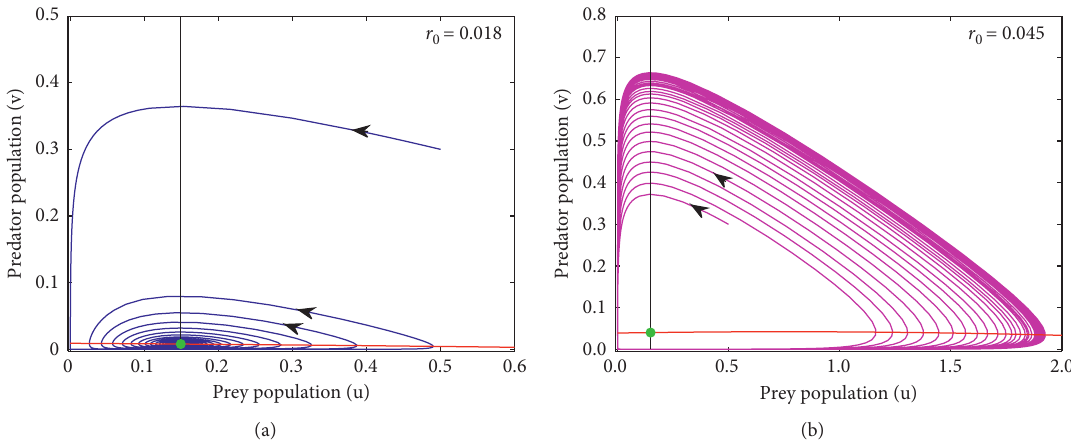
Figure 4: The phase portrait diagram of (4) around the coexisting singular point E ∗ (green filled circle) with initial values [ x ( 0 ) , y ( 0 )] � [ 0 . 5 , 0 . 3 ] . Black vertical line represents the predator isocline, and the red curve represents the prey isocline. The subplot (a) shows the phase portrait diagram is stable asymptotically at E ∗ ( 0 . 1493 , 0 . 0078 ) for r limit cycle oscillation around E ∗ ( 0 . 1493 , 0 . 0400 ) for r � 0 . 5. and δ 2